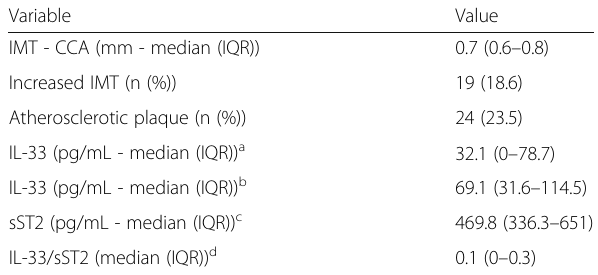
Table 2 Results of carotid artery ultrasounds and IL-33 and